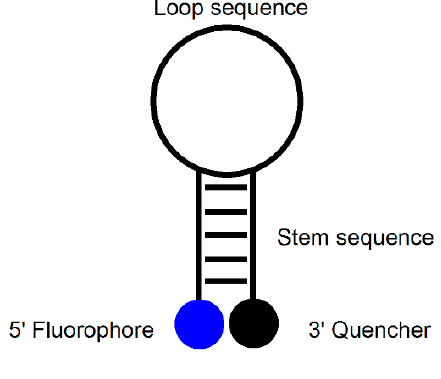
Figure 1. MB probe. Figure 1. MB probe.